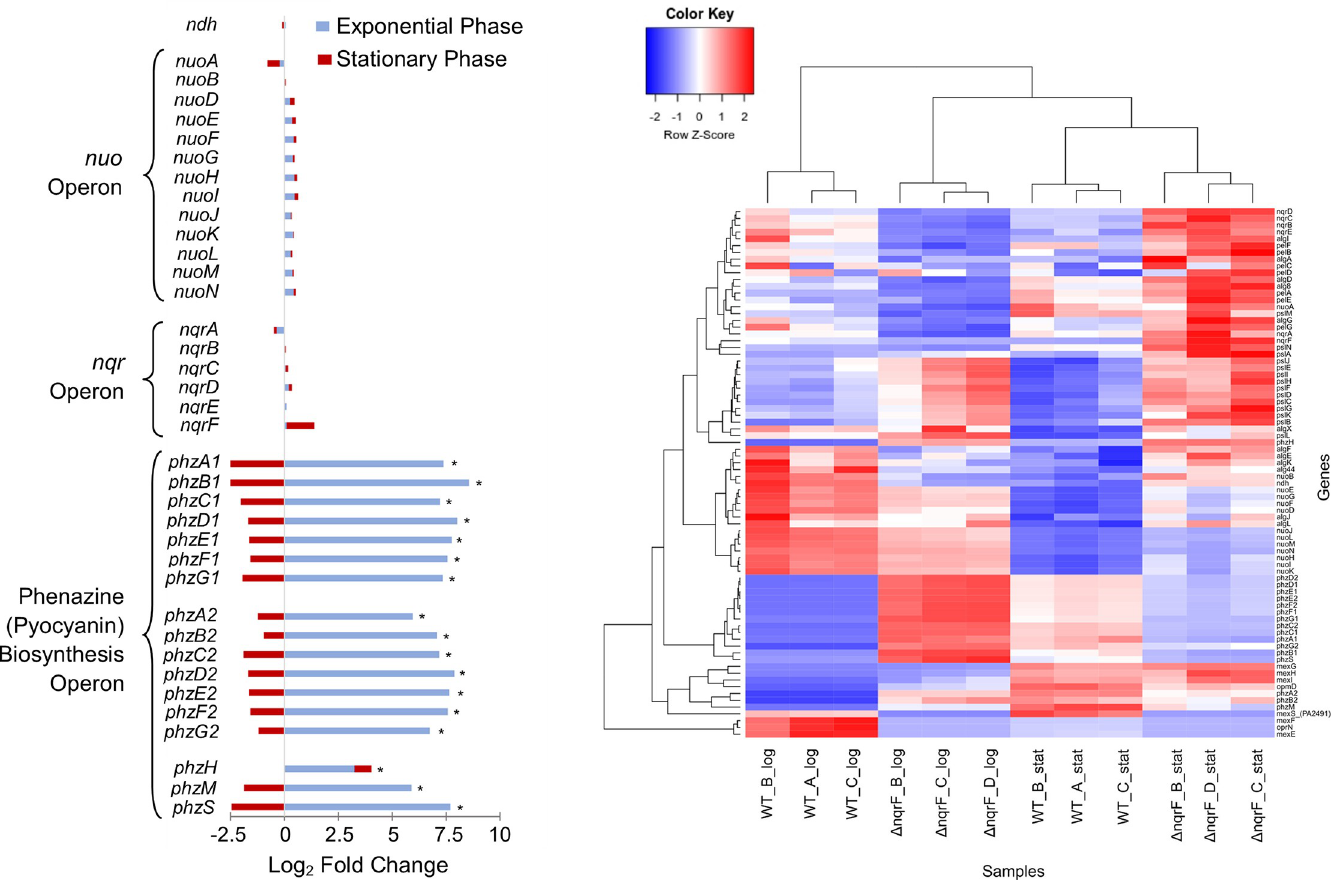
Fig 6. Transcriptome analysis of the Δ nqrF mutant strain compared to wild type. A. Differential expression of genes encoding NDH2, NUO, and the pyocyanin biosynthesis operons in the Δ nqrF mutant strain compared with wild type PAO1 during exponential and stationary phases. A positive value indicates an increased expression in Δ nqrF compared to wild-type. Stars indicate significant changes in expression with a P-value < 0.05 as determined via the calculations outlined in Materials and Methods. B. Heatmap of gene expression profiles in the transcriptome profiles of three biological replicates of the Δ nqrF and wild type strains in exponential and stationary phase. Select genes include those encoding ndh , nuo operon , pyocyanin biosynthesis ron, extracellular polysaccharides alg , psl , and pel operons, the genes coding for the MexEF-OrpN efflux pump and related genes and the MexGHI-OpmD efflux pump. All genes were normalized by gene length and χ 2 transformed before analysis. Most highly expressed genes were selected according to the sum of normalized counts across samples. Genes were selected from the NOISeq results and counts were χ 2 transformed before analysis. According to the Z-score, color bars in red correspond to higher expression.